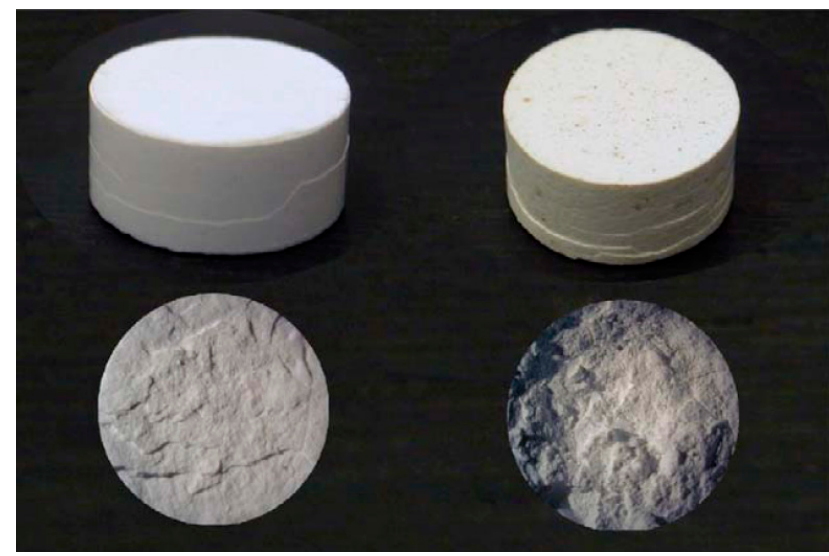
Figure 4. Mg(NH 3 ) 6 Cl l2 for ammonia storage